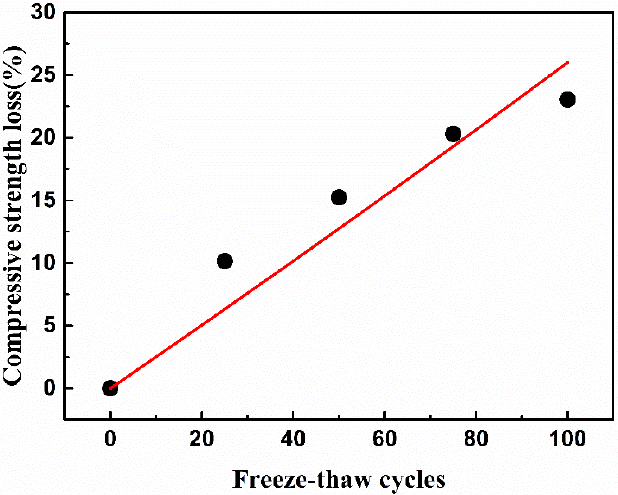
Figure 11. Fitting curve of strength loss of permeable concrete under freeze-thaw cycles.